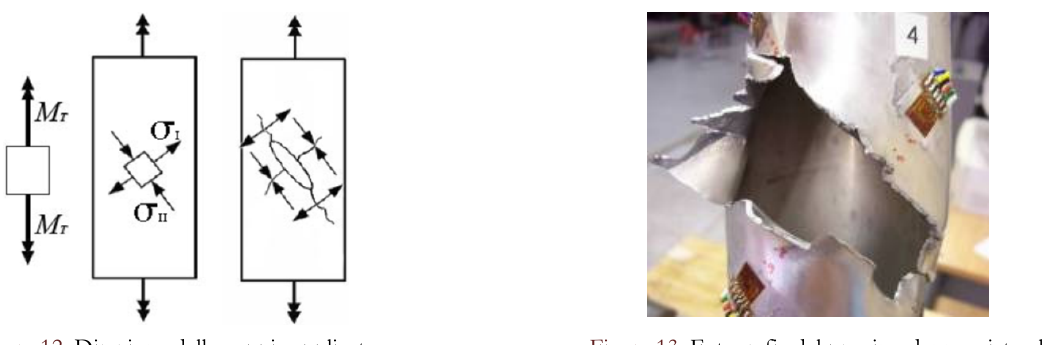
termine della prova